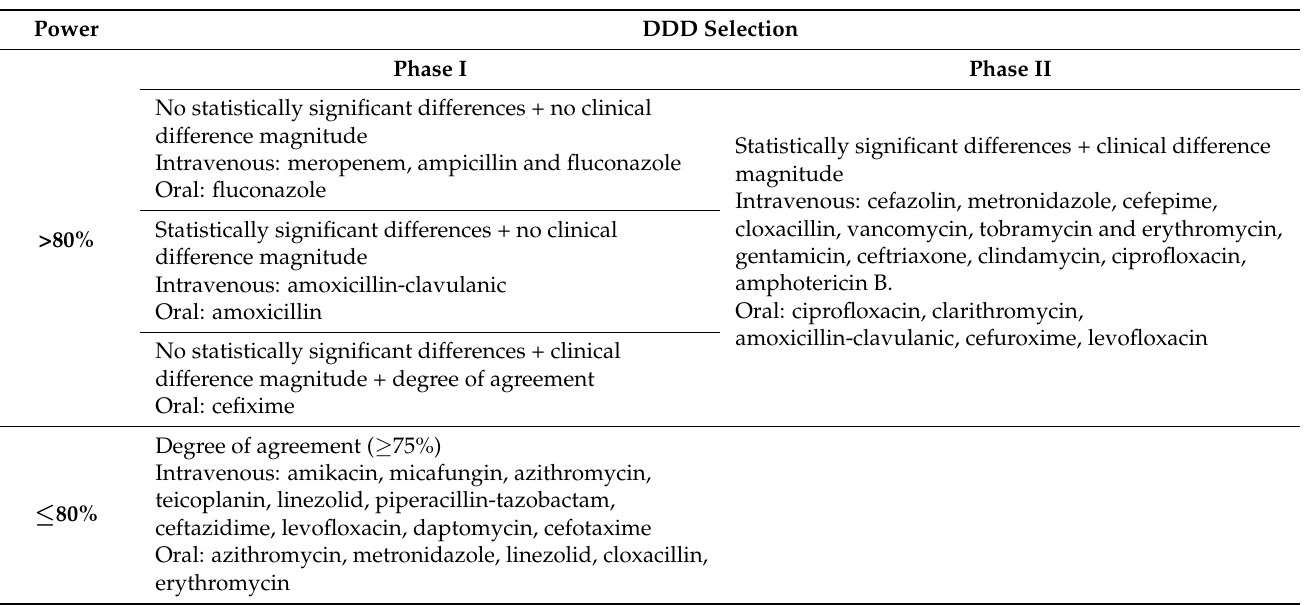
Table 5. Selection of DDD for each antibiotic based on the established